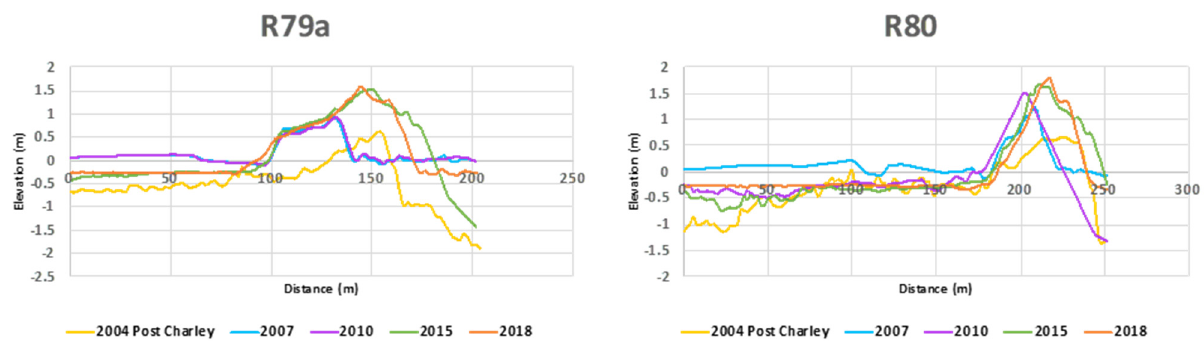
Figure 6. R79a and R80 elevation profiles with respect to NAVD88 of North Captiva Island for 2004 post-Charley through 2018.